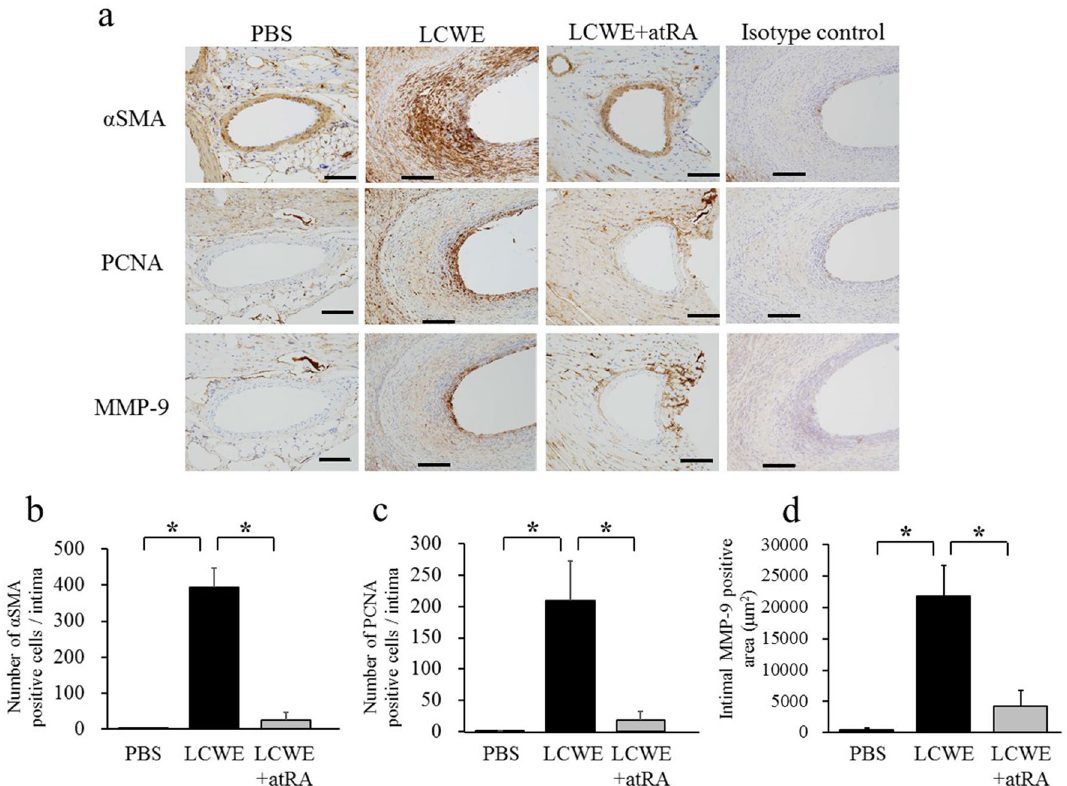
Figure 4. Immunohistochemical staining of α-SMA (upper), proliferating cell nuclear antigen (PCNA) (middle), and matrix metalloproteinase-9 (MMP-9) (bottom) in mice with PBS, LCWE and LCWE + atRA (a) . All positive cells are shown as a brown color. Isotype antibodies were used as negative control; α-SMA: mouse polyclonal IgG2a kappa, PCNA: rabbit IgG, MMP-9: mouse monoclonal IgG1a kappa. Scale bar = 100 μm. The number of intimal αSMA- (b) and PCNA-positive cells (c) and the intimal MMP-9-positive area (d) in mice treated with PBS (n = 5), LCWE (n = 6) and LCWE + atRA (n = 7) were quantitatively analyzed and compared among the groups. The data are expressed as the mean ± SD. *p < 0.0001. All the data were generated from 1 experiment at the same